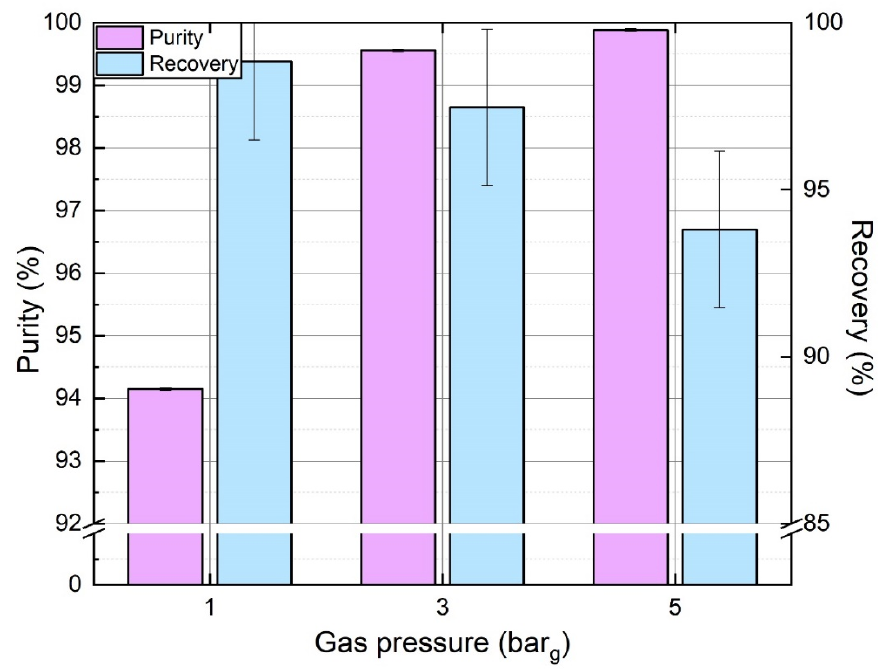
Figure 6. Effect of gas phase pressure on N 2 purity and recovery rate. ( Q l = 150 L.h − 1 , Q g = 100 NL h − 1 , y in : = 35%, 1 M KCl solution). CO 2